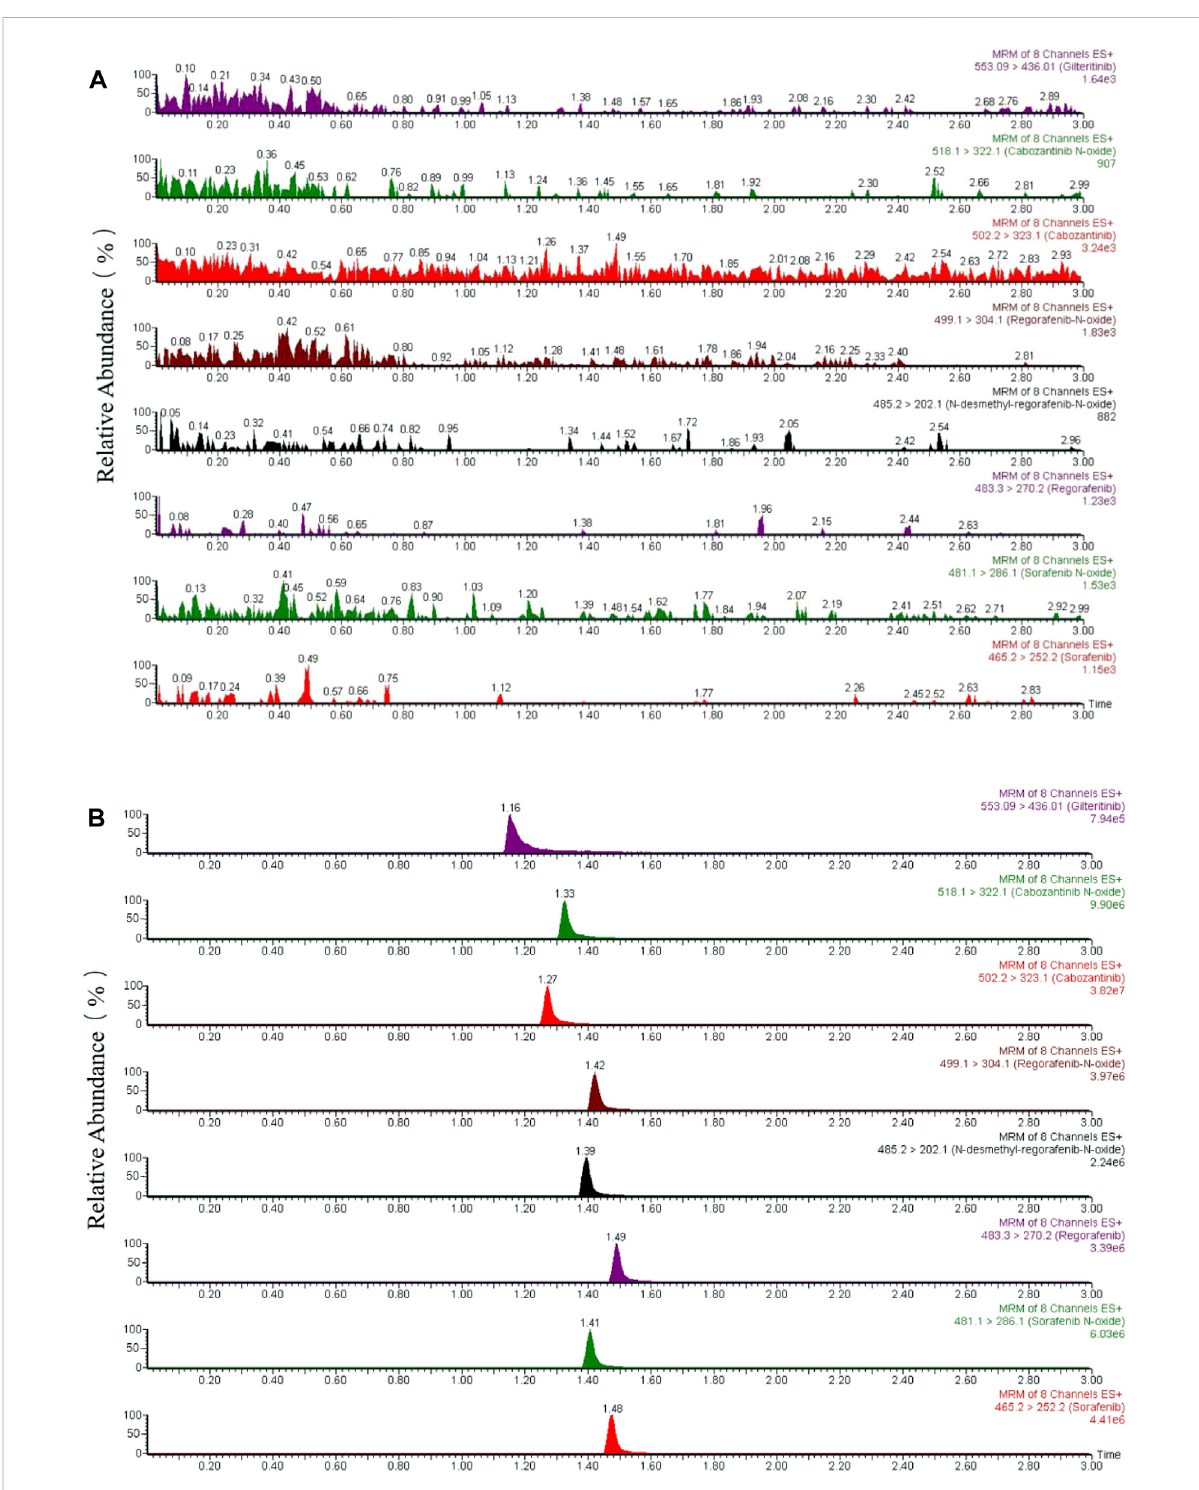
FIGURE 2 Representative chromatograms of sorafenib, regorafenib, cabozantinib, gilteritinib (IS) and metabolites of sorafenib N-oxide,